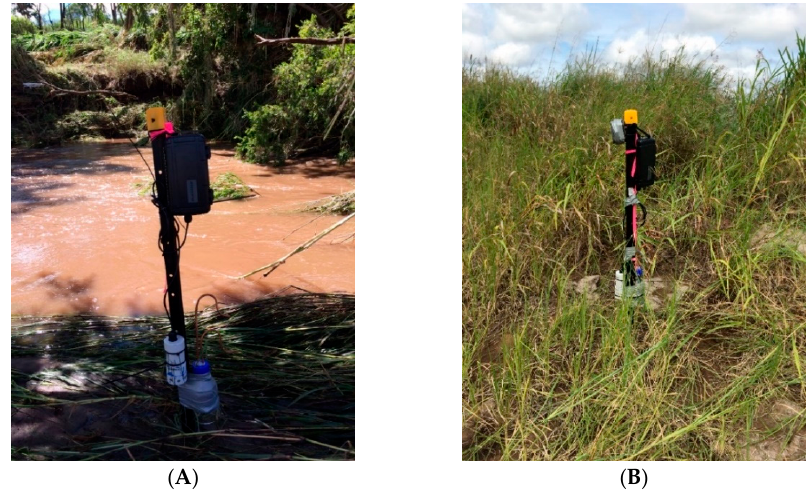
Figure 3. Field installation of low-cost total suspended sediment (TSS) sensors and single stage samplers on star pickets. ( A ) Installation directly adjacent to stream. ( B ) Upslope installation on a rehabilitated bank